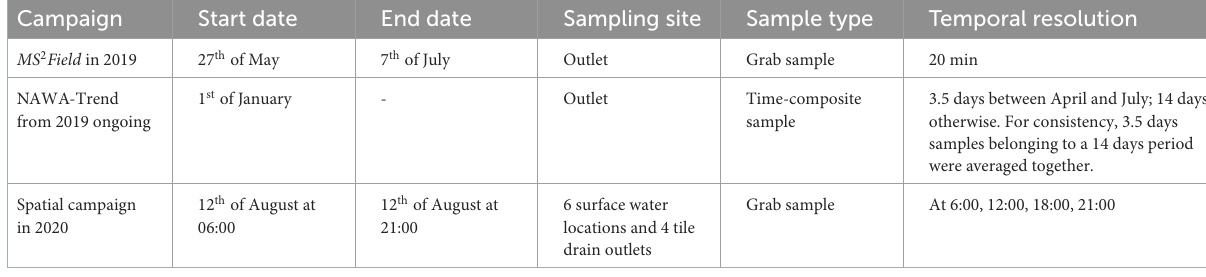
TABLE 1 Overview of the sampling campaigns detailing the monitored time window, the location of the sampling, the type of sample collected and the temporal resolution of the campaign. Campaign